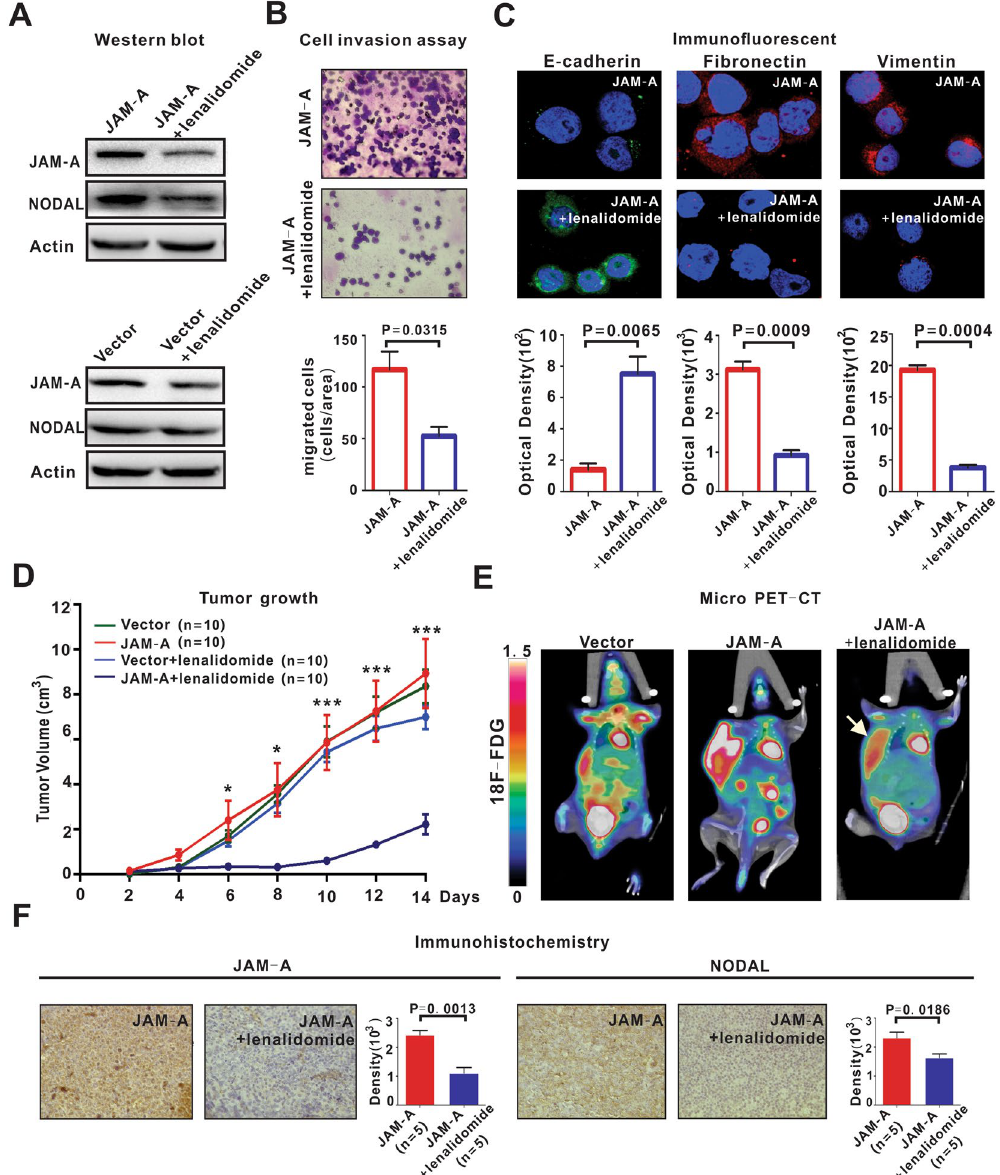
Figure 5. Lenalidomide inhibited lymphoma progression. ( A ) Lenalidomide (1 μ M) downregulated JAM-A and NODAL expression more significantly in JAM-A-transfected DB cells as compared to vector- transfected cells. ( B , C ) Lenalidomide (1 μ M) inhibited JAM-A-transfected cell invasion ( B ) and EMT ( C ). ( D ) In murine xenograft model established with subcutaneous injection of DB cells, tumor size was similar between vector-transfected (Vector) and JAM-A-transfected (JAM-A) group. Lenalidomide (25 mg/kg/day, JAM-A + lenalidomide) retarded tumor growth. * P < 0.05 and *** P < 0.001 comparing with the JAM-A group. ( E ) By micro-PET-CT, JAM-A overexpression contributed to tumor metastasis, all involving endoderm- and mesoderm-associated organs, which was inhibited by lenalidomide. ( F ) Lenalidomide downregulated JAM-A and NODAL expression. Data in ( B ) and ( C ) are representative of three independent